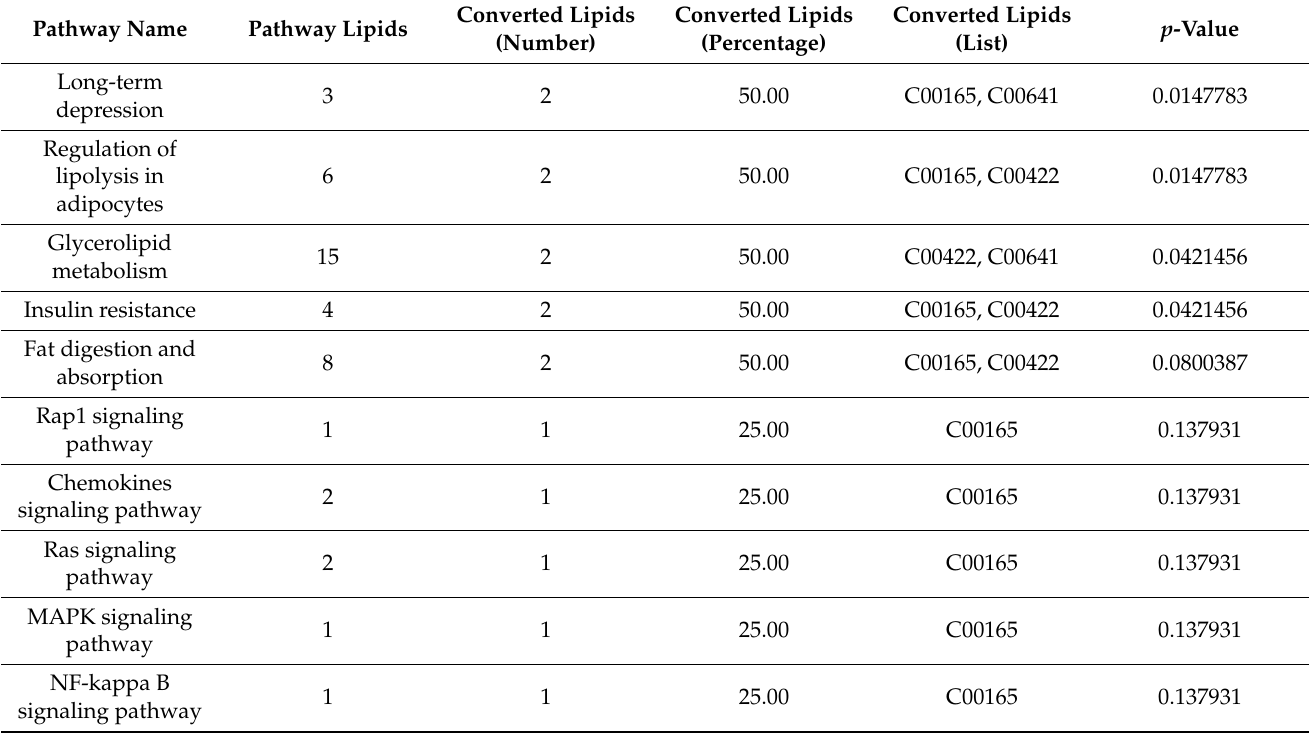
Table 2. Pathway enrichment analysis of the significant lipids and their p